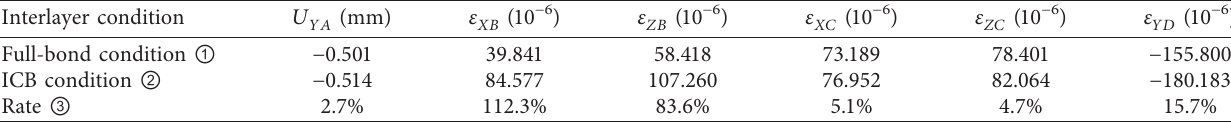
Table 3: Responses at the higher